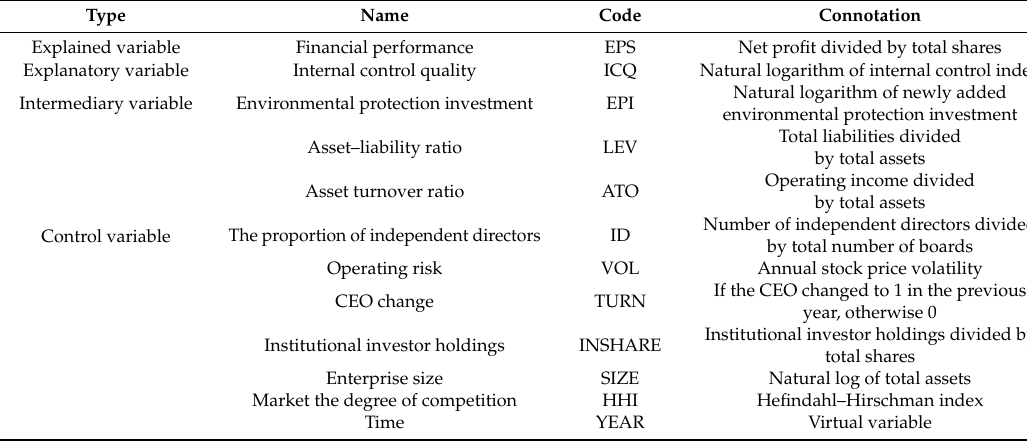
Table 1. Variable